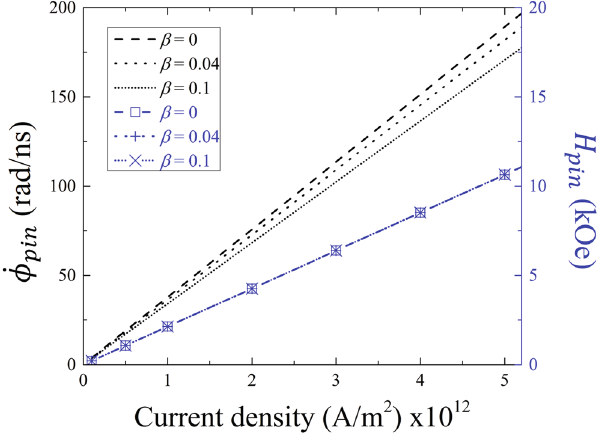
Figure 2. Estimation of the angular velocity φ  (obtained from Eq. 4, black lines) and magnetic field H zpin pin (obtained from Eq. 3, blue lines and symbols) of the DW for different current